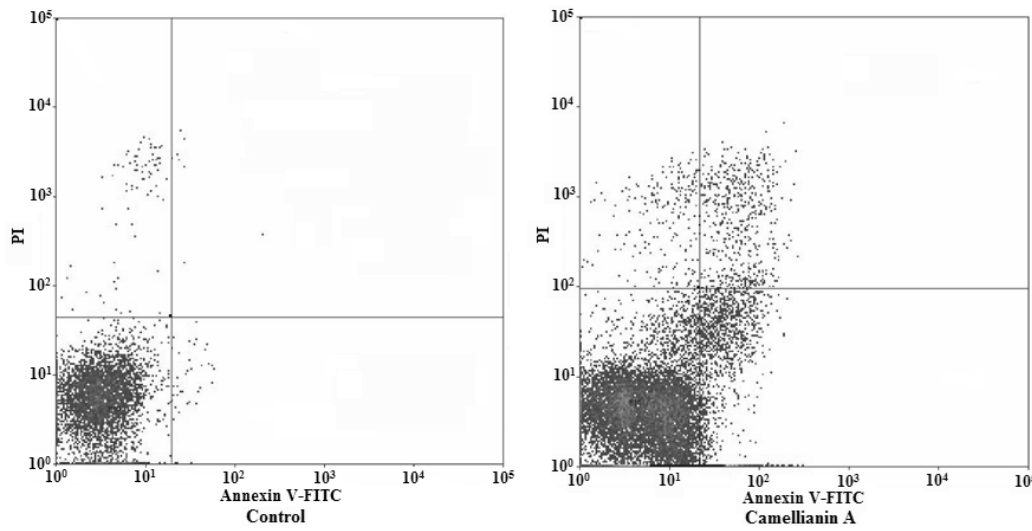
Figure 9. Flow cytometric analysis of phosphatidylserine externalization and cell membrane integrity in Hep G2 cells undergoing